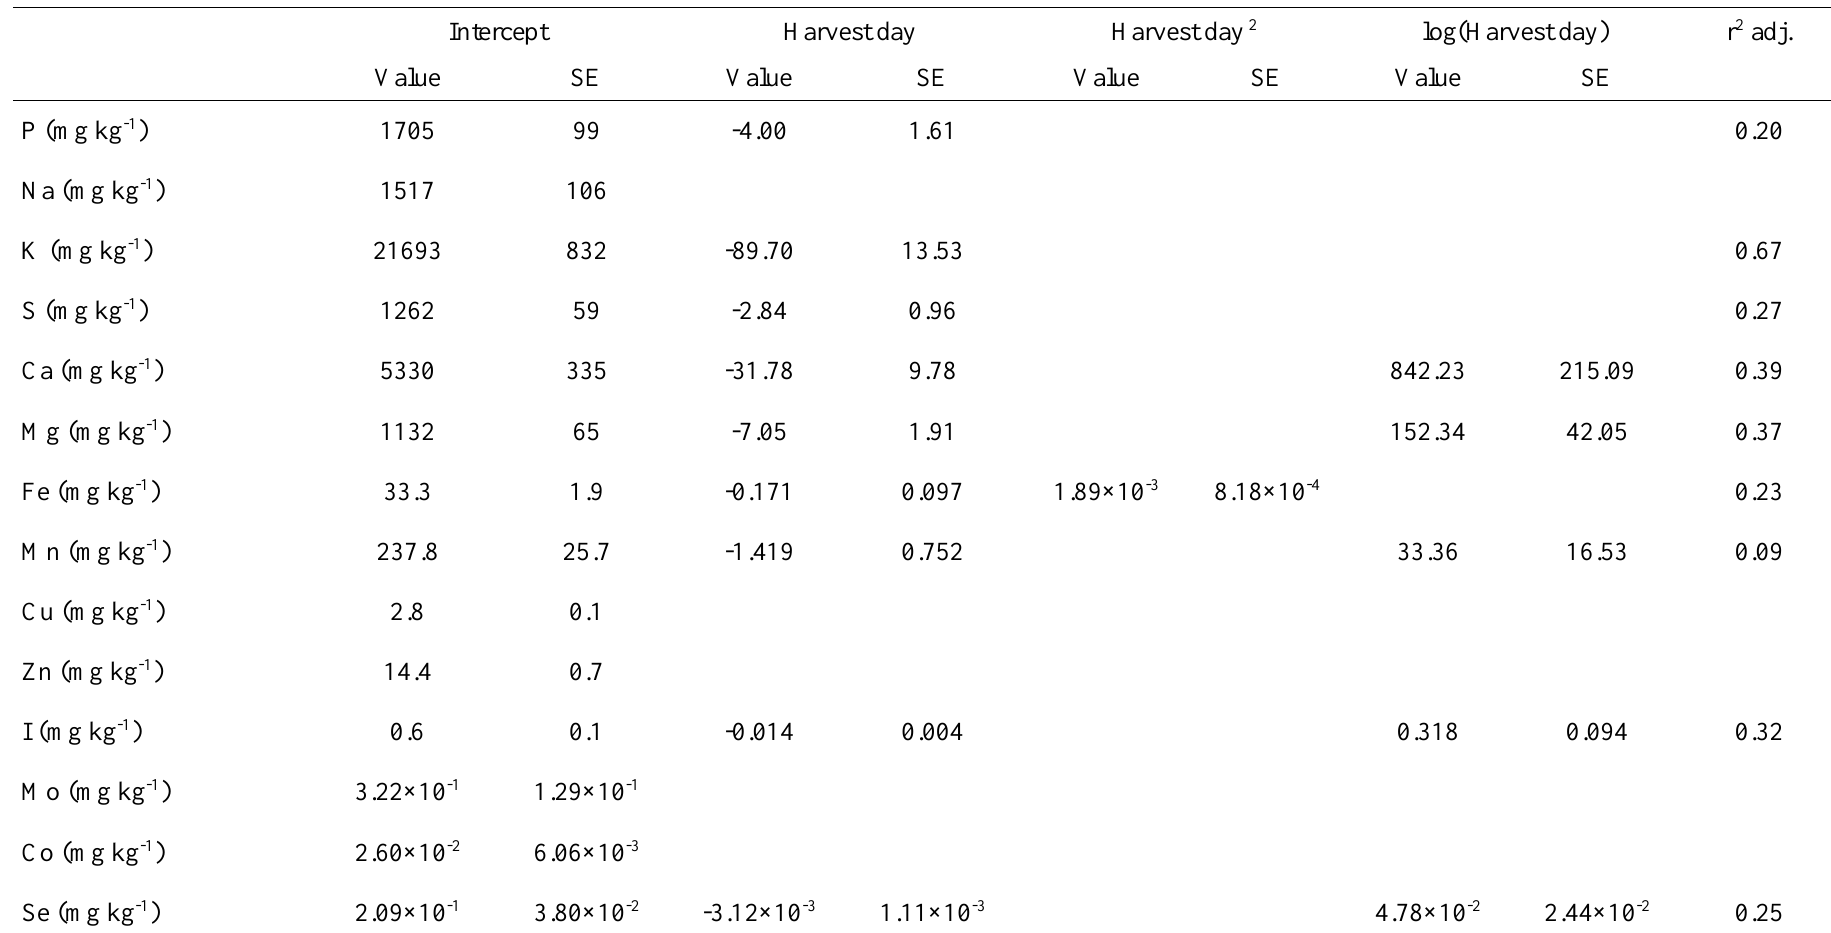
Table 4. Experiment II: Effect of harvest day on dry matter mineral contents of T. latifolia biomass one year after planting. Fitted parameters to the (maximum)